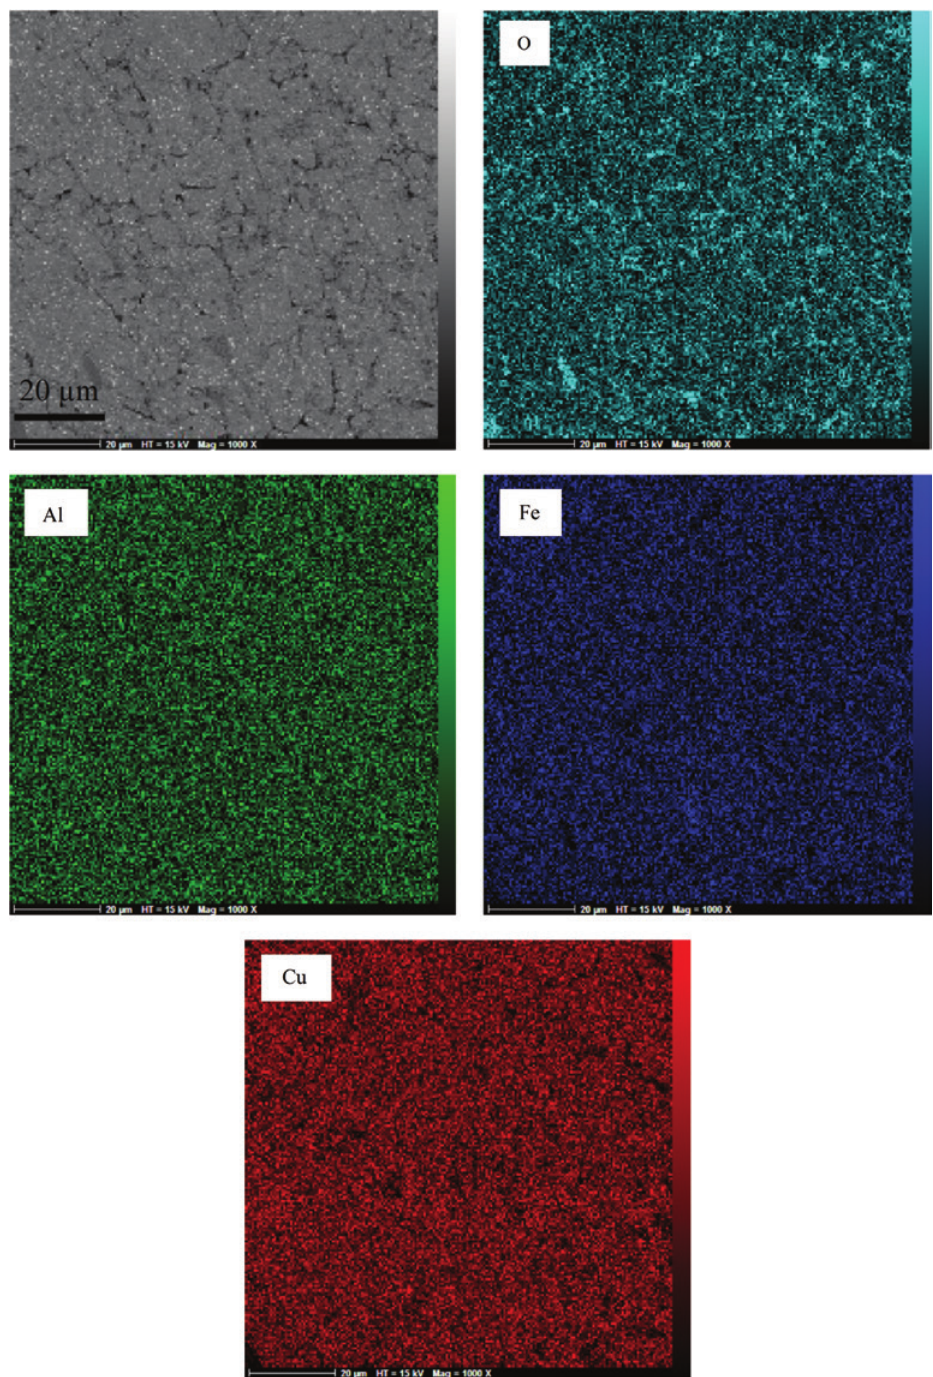
Figure 7: EDS distribution maps of Fe, O, Al and Cu for sample CuFe(alumina) nanocomposite.